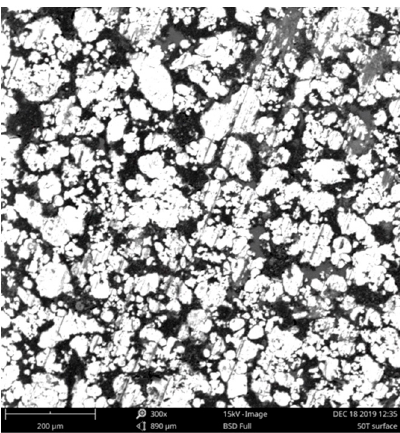
Figure 6. Surface microstructure photograph for compaction pressure 390 MPa.